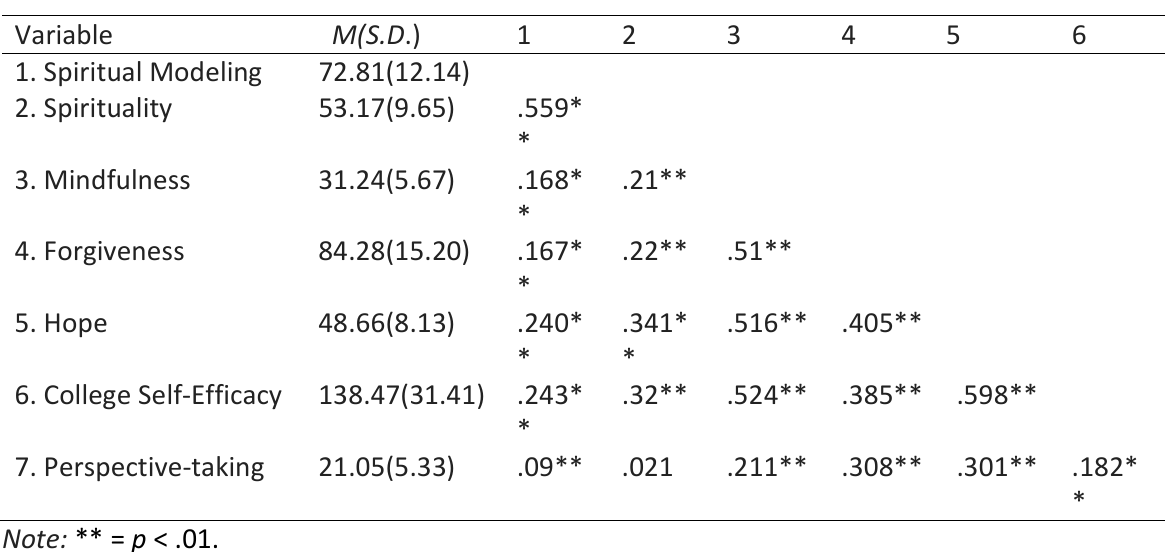
Table 1. Descriptives and correlations